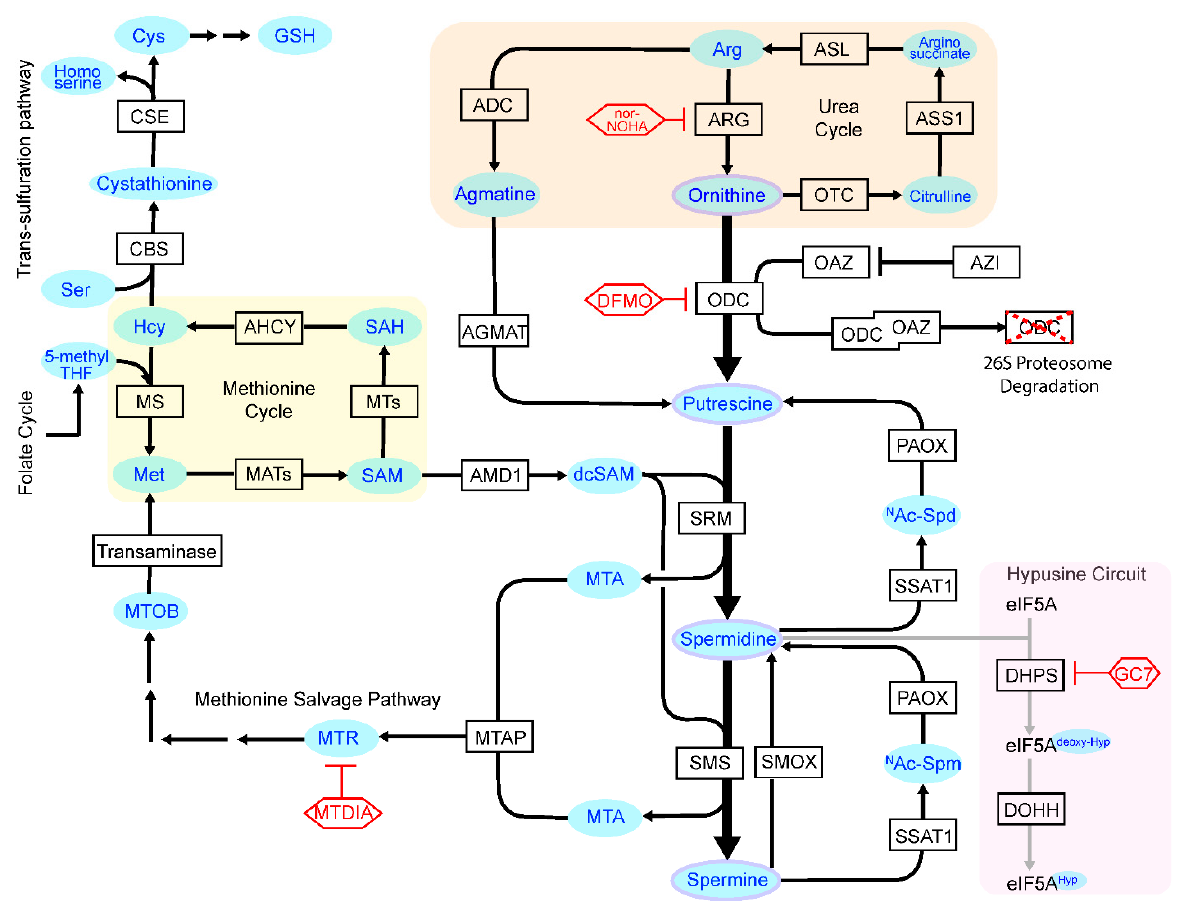
Figure 1. Polyamine metabolism and interacting pathways. Enzymes that control central polyamine biosynthesis and catabolism are shown, as well as the metabolic circuits that feed into the control of polyamine homeostasis. Light blue, substrates and products; red, inhibitors of key enzymes. ADC, Arginine decarboxylase; AHCY, S-adenosylhomocysteine hydrolase; AMD1, Adenosylmethionine decarboxylase-1; AGMAT, Agmatinase; Arg, Arginine; ARG, Arginase;